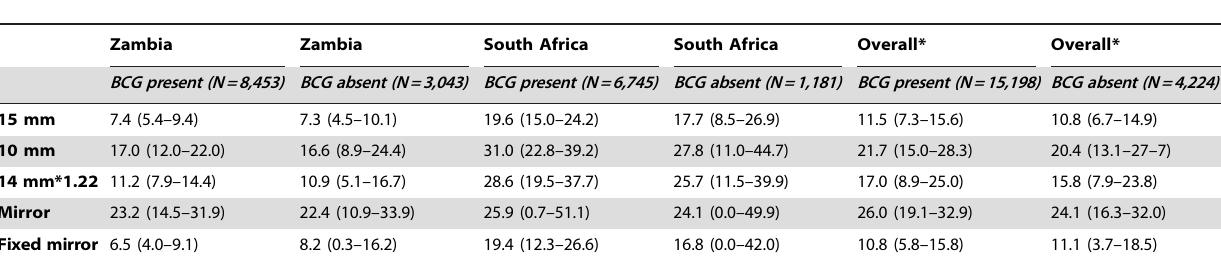
Table 3. Tuberculous infection prevalence estimates (95% confidence intervals) by country and overall.